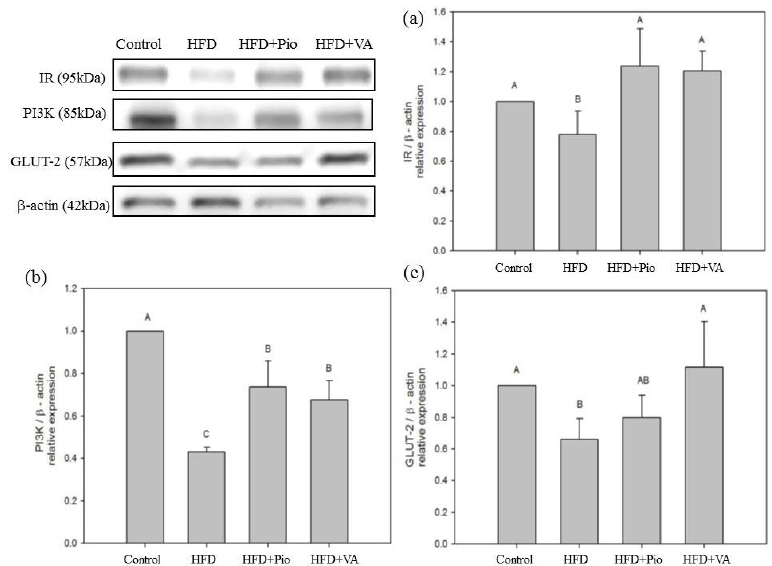
Figure 2. Hepatic ( a ) insulin receptor (IR); ( b ) phosphoinositide 3 ‐ kinase (PI3K); and ( c ) glucose transporter 2 (GLUT ‐ 2) proteins expression in rat fed high ‐ fat diet for 16 weeks and orally administered vanillic acid during the last 4 weeks. Control: normal diet; HFD: high ‐ fat diet (60 kcal % fat); HFD + Pio: HFD (60 kcal % fat) + pioglitazone (30 mg/kg body weight); HFD + VA: HFD (60 kcal % fat) + vanillic acid (30 mg/kg body weight); (A–C) indicate statistically significant differences p < 0.05. Data are presented as mean ± SD (3 rats in each group). Nutrients 2015 , 7 , page–page